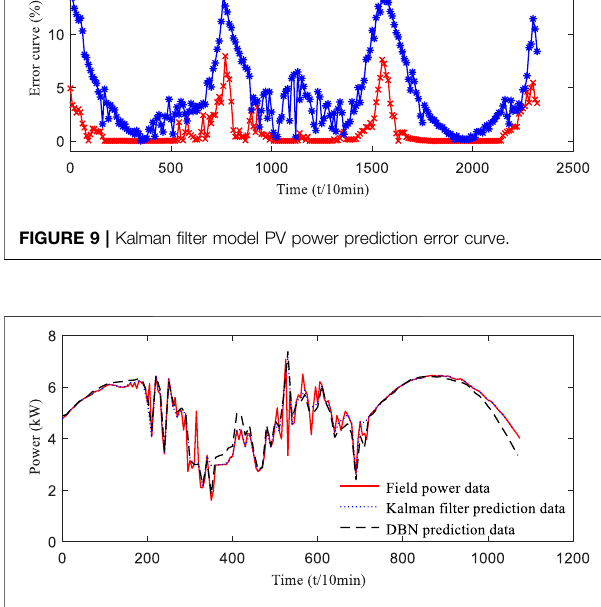
FIGURE 10 | Comparison curve of Kalman fi lter and DBN prediction